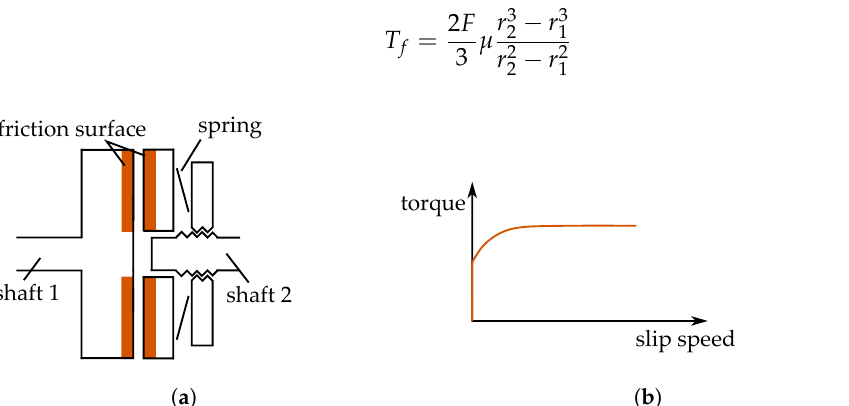
Figure 7. Friction type torque limiter: ( a ) Cross-section diagram ( b ) Representative torque vs. slip speed